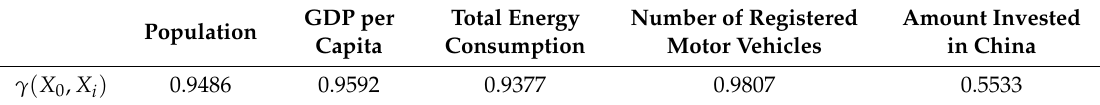
Table 3. Grey relational degree between CO 2 emission amount and